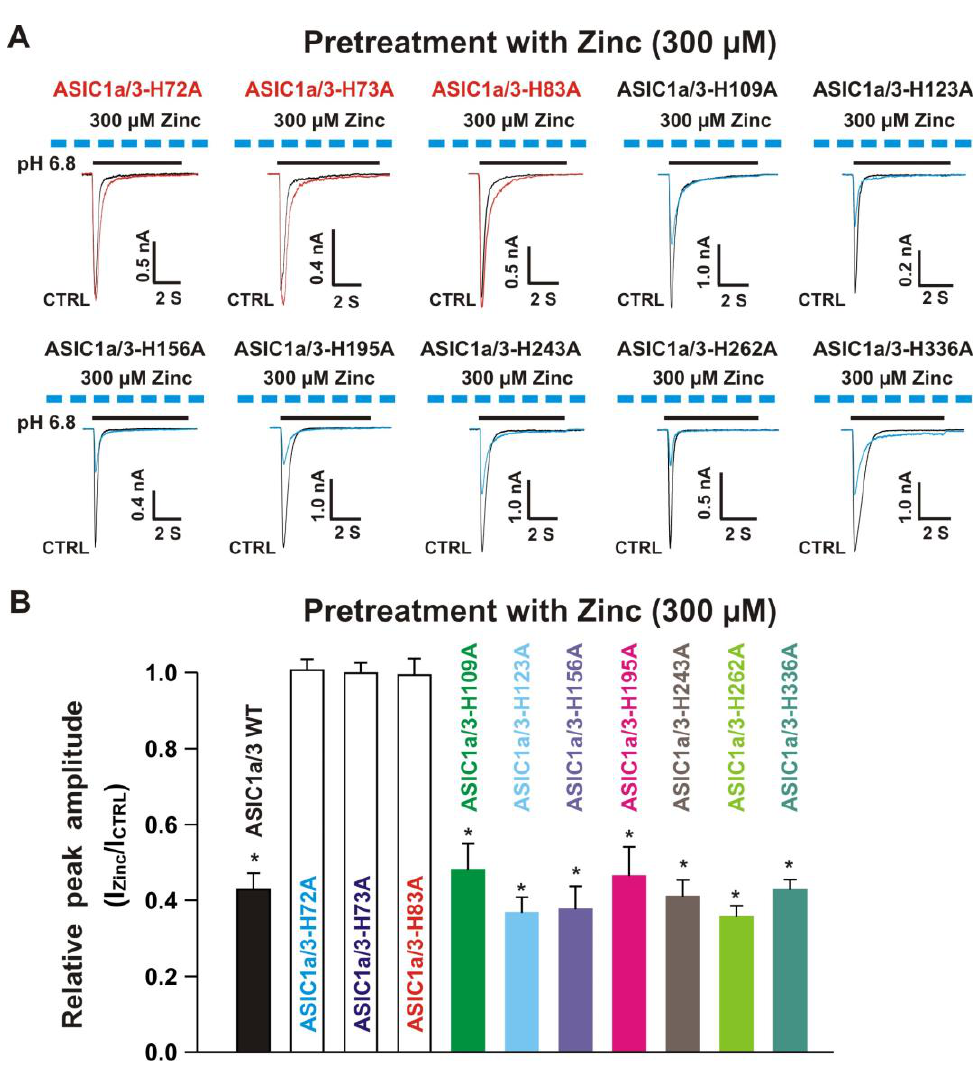
Figure 13. Effects by pretreatment with 300 µM zinc on currents recorded from ASIC1a WT co-expressed with ASIC3 histidine mutants on CHO cells. ( A ) Representative traces show that pretreatment with zinc at a concentration of 300 µM inhibited the peak amplitude of the currents recorded from heteromeric ASIC1a/3-H109A, ASIC1a/3-H123A, ASIC1a/3-H156A, ASIC1a/3-H195A, ASIC1a/3-H243A, ASIC1a/3-H262A, and ASIC1a/3-H336A, but not ASIC1a/3-H72A, ASIC1a/3-H73A, and ASIC1a/3-H83A. The dashed blue line represents pretreatment with 300 µM zinc in the pH 7.4 solution with a duration of 2 min; ( B ) Statistical bar graphs show relative peak amplitudes of the currents by pretreatment with 300 µM zinc from ASIC1a/3 WTs and ASIC1a with ASIC3 histidine mutants as mentioned above ( n = 7 to 15). Pretreatment with zinc at a concentration of 300 µM did not affect the peak amplitude of the currents without zinc treatment on ASIC1a/3-H72A, ASIC1a/3-H73A, and ASIC1a/3-H83A ( p > 0.05, t-test). There was no significant difference for zinc inhibition among ASIC1a/3 WT, ASIC1a/3-H109A, ASIC1a/3-H123A, ASIC1a/3-H156A, ASIC1a/3-H195A, ASIC1a/3-H243A, ASIC1a/3-H262A, and ASIC1a/3-H336A ( p > 0.05, ANOVA). For ASIC3 mutation, histidine residues in the extracellular domain of ASIC3 were replaced with alanine. Whole-cell patch-clap recording was performed, and currents recorded from heteromeric ASIC1a/3 WTs and ASIC1a WT with ASIC3 histidine mutants were triggered by a drop in pH from 7.4 to 6.8. Data are presented as mean ± SEM. CTRL, control; I CTRL , ASIC current without any treatment; I Zinc , ASIC current by zinc treatment. * p < 0.05 (t-test).